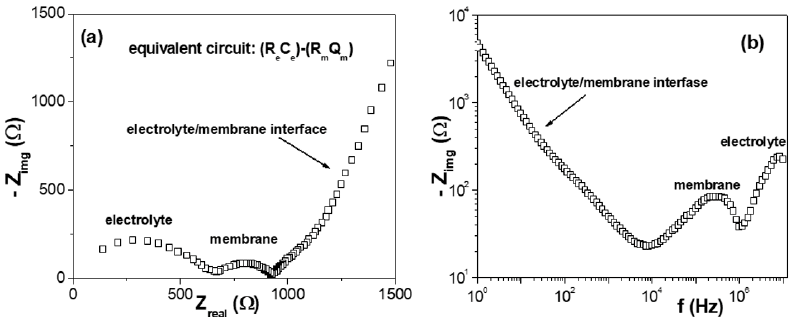
Figure 3. Impedance plots for the 26% AlqCl/74% CTA membrane separating two NaCl solutions at 0.03 M concentration. ( a ) Nyquist plot ( − Z img vs. Z real ); ( b ) Bode plot ( − Z img vs. frequency).